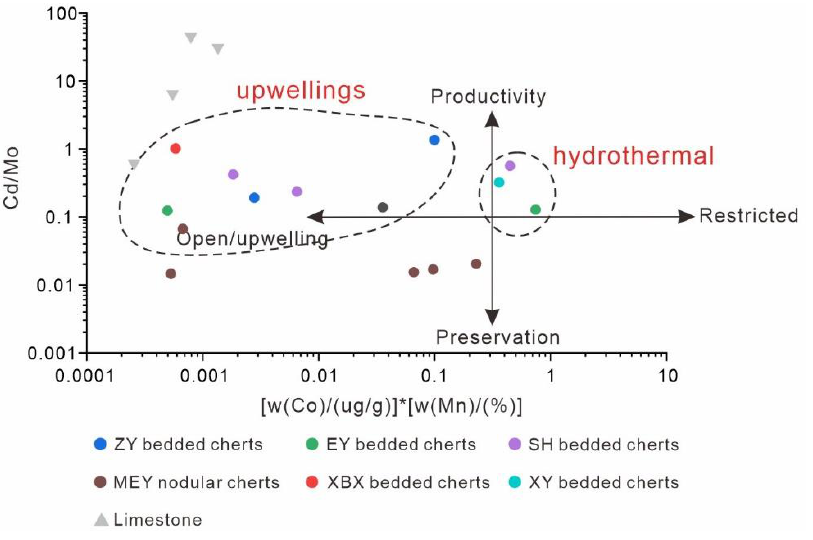
Figure 10. Co * Mn versus Cd/Mo diagram for the Maokou cherts to identify upwelling settings. Figure 10. Co*Mn versus Cd/Mo diagram for the Maokou cherts to identify upwelling